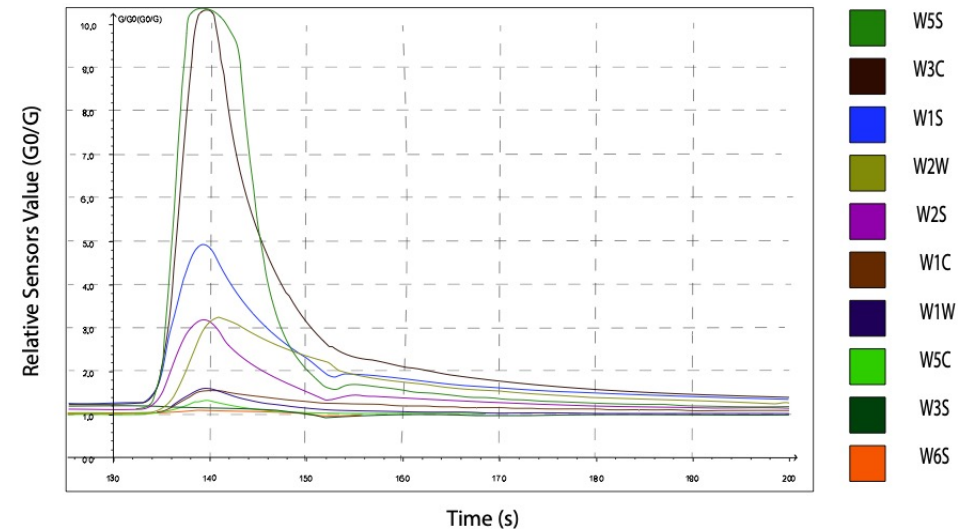
Figure 2. Typical output of the PEN3 to a late CRC urine samples, where each curve representing output from a different sensor.